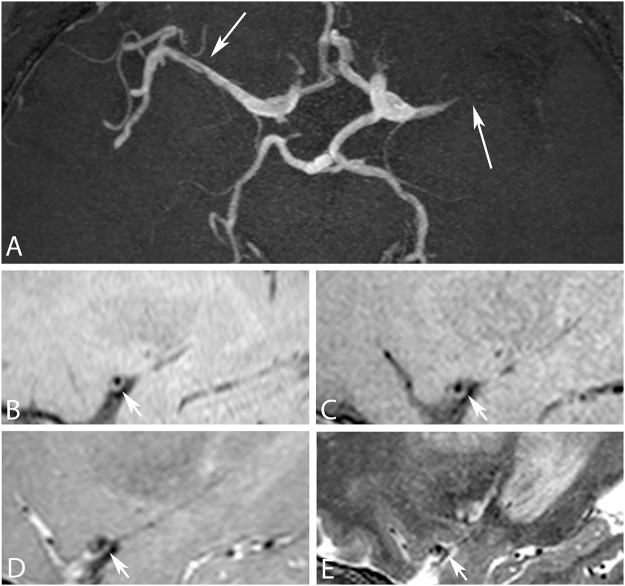
Comparison between four different 3D intracranial vessel wall sequences at 3 tesla in a 47-year-old male patient presented with a bilateral partial anterior circulation infarct as caused by an occlusion and stenosis in the left and right middle cerebral artery (MCA), respectively.(A) On the transverse 3D time-of-flight magnetic resonance angiography two stenoses can be appreciated, one in the left M1 segment of the MCA and one in right M1 segment of the MCA (arrows). (B) Sagittal reconstruction of the transverse T1w VIRTA, (C) sagittal T1w VIRTA, (D) sagittal PDw and (E) sagittal T2w images showing a vessel wall lesion in the left middle cerebral artery (arrows). On both T1w VIRTA images and the PDw image the plaque can be clearly delineated, however on the T2w image the vessel wall is less clear.